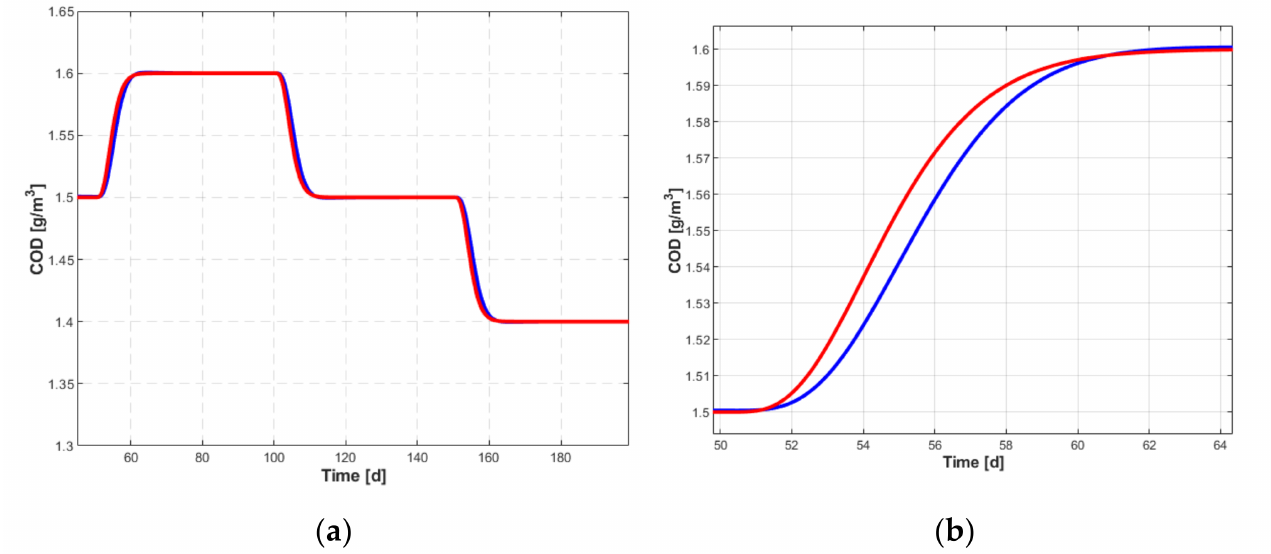
Figure 14. Setpoint tracking: setpoint COD ref (red), controlled variable (COD —blue) ( a ); zoom ( b